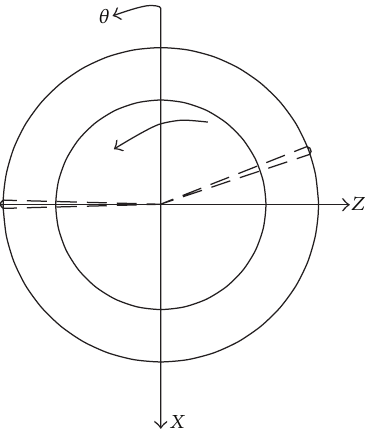
Figure 4: Up-Hz configuration of two-groove oil journal bearing.